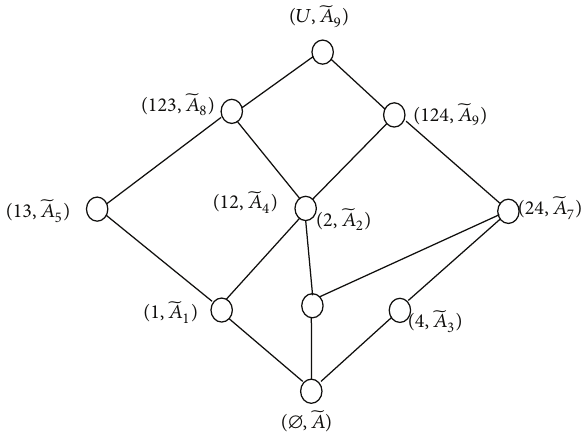
Figure 1: Concept lattice of the IF formal context (𝑈,𝐴, ̃𝐴 = {(𝑎, 0.8, 0.1) , (𝑏, 0.7, 0.2) , (𝑐, 0.2, 0.5) 4